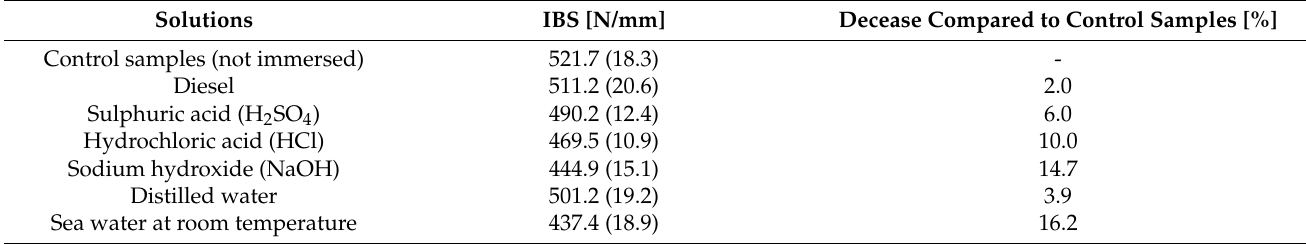
Table 3. Impact bending stiffness (IBS) and respective comparision with the value obtained for control samples. Solutions IBS [N/mm] Decease Compared to Control Samples [%] Control samples (not immersed) 521.7 (18.3) - Diesel Sulphuric acid (H 2 SO 4 ) Hydrochloric acid (HCl) Sodium hydroxide